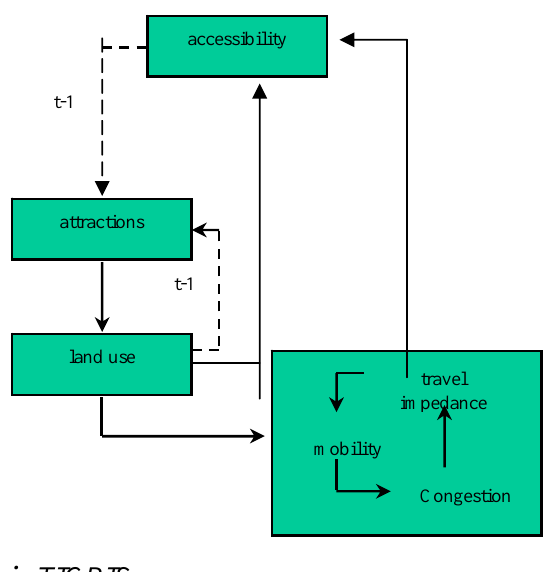
Figure 1: Interactions in TIGRIS Submodels in TIGRIS